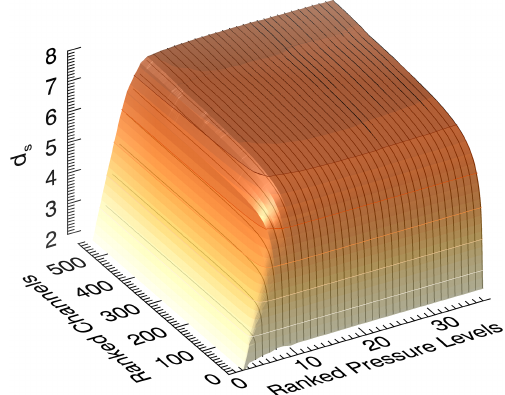
Figure 2. DFS for a temperature retrieval with IASI vs. both ranked atmospheric pressure levels and ranked spectral channels from the CO 2 spectrum. The black lines show contours of number of pres- sure levels and the coloured highlight lines show contours of integer